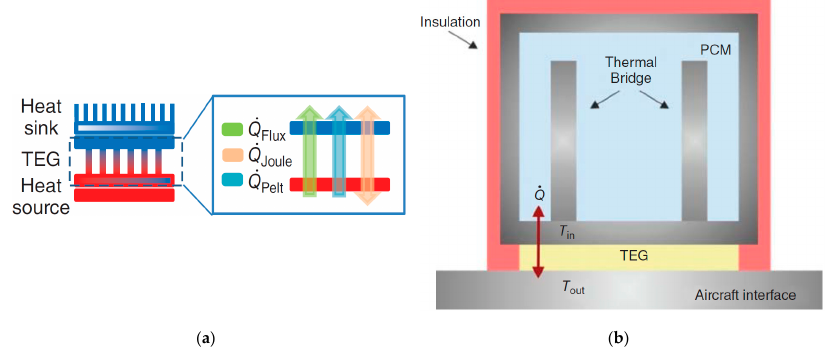
Figure 25. Static ( a ) and dynamic ( b ) TEG configurations used in airplanes’ fuselages [150].